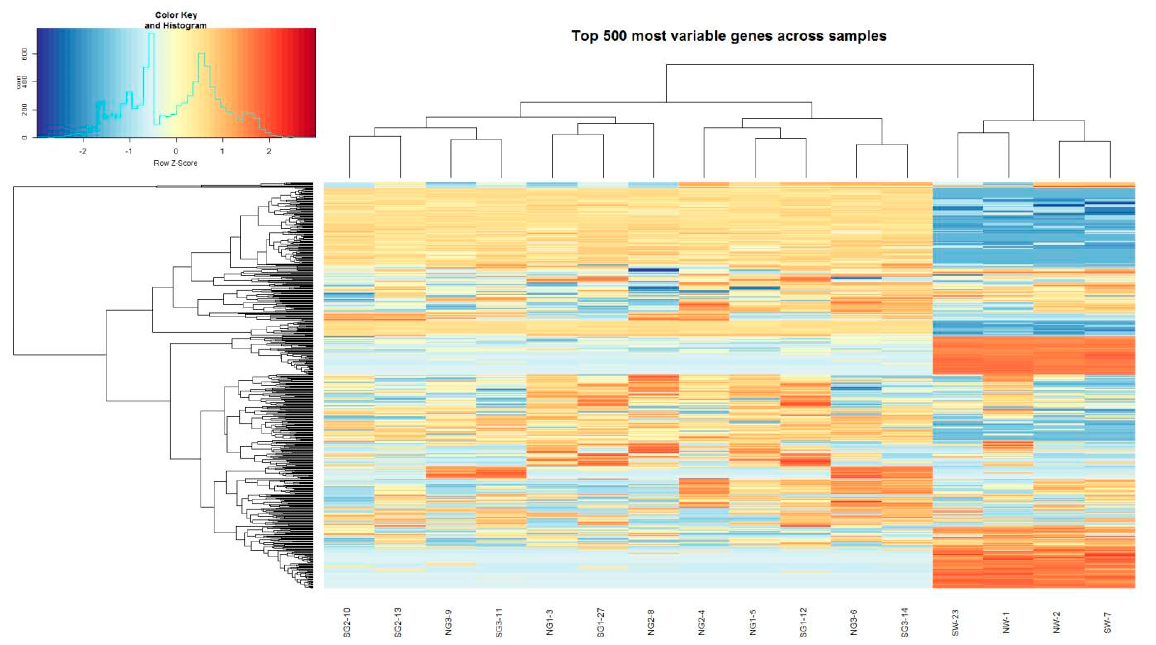
Figure 5. Expression changes of all genes. The volcano map displays expression changes of all genes. Blue represents differentially expressed genes (Log-fold change > 2.0 or Log-fold change <